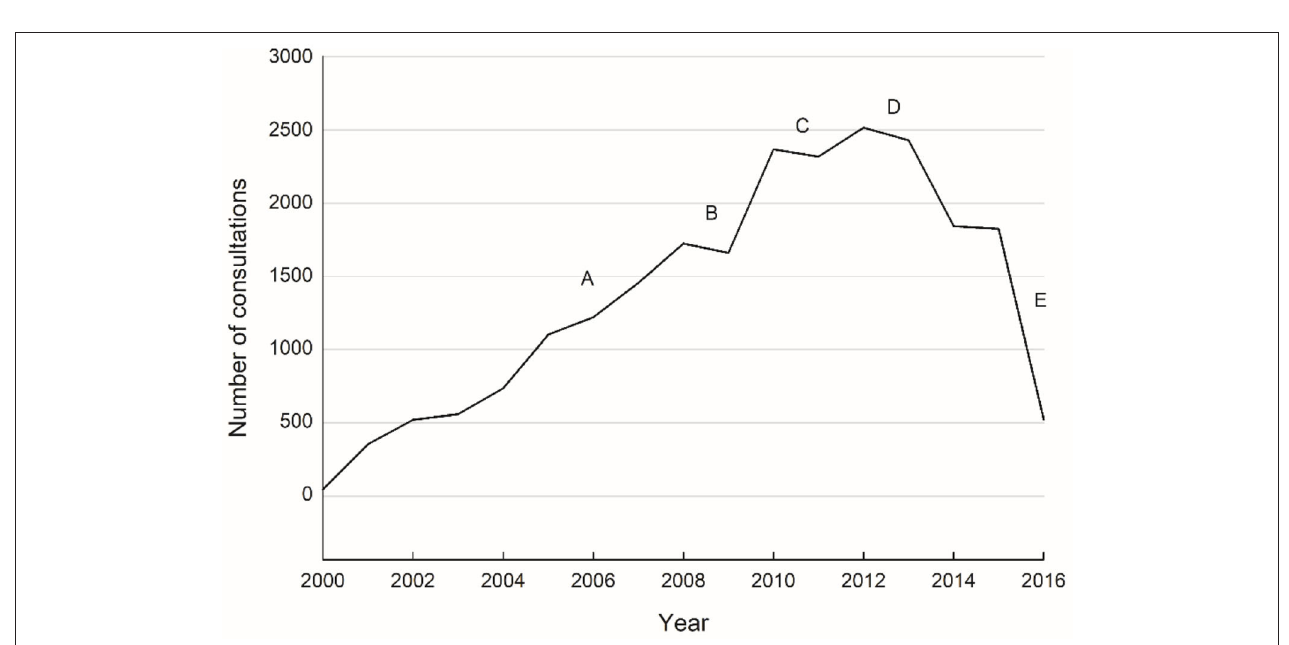
FIGURE 4 | All QTS consultations over time (November 2000 to March 2016). Milestones: (A) mobile videoconferencing systems deployed for regional paediatric ward rounds; (B) mobile ENT surveillance service established; (C) QTS operational budget reduced; (D) staged closure of the RCH; and (E) transfer of the QTS to the new Queensland Children’s Hospital in